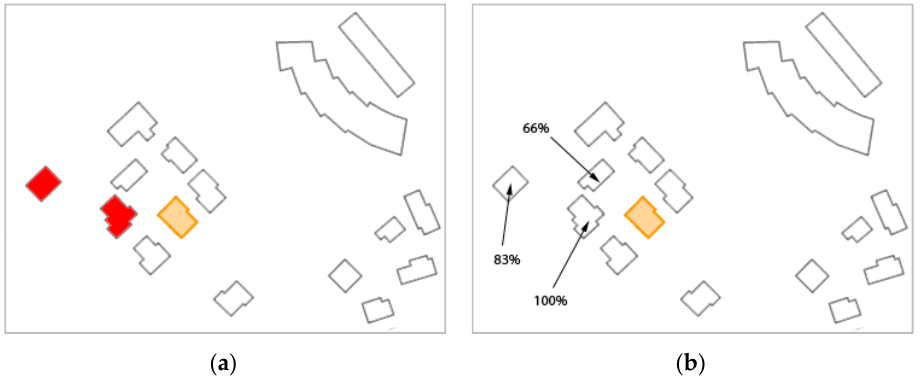
Figure 21 . Results of the west_of relation with respect to the selected building: ( a ) from the application; ( b ) from the user tests.